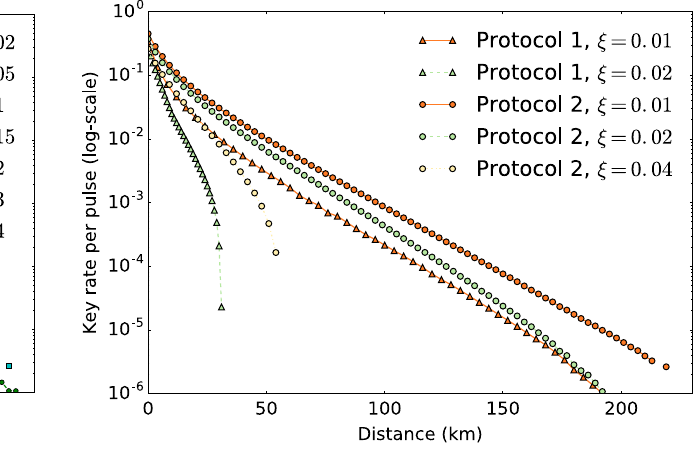
FIG. 8. Secure key rate versus transmission distance for a direct comparison between protocols 1 and 2. Curves for protocol 1 are plotted with triangle markers (from Fig. 4); the excess noise is ξ ¼ 0 . 01 , 0.02 from top to bottom for curves with triangle markers. Curves for protocol 2 are plotted with circle markers (from Fig. 7); the excess noise is ξ ¼ 0 . 01 , 0.02, 0.04 from top to bottom for curves with circle